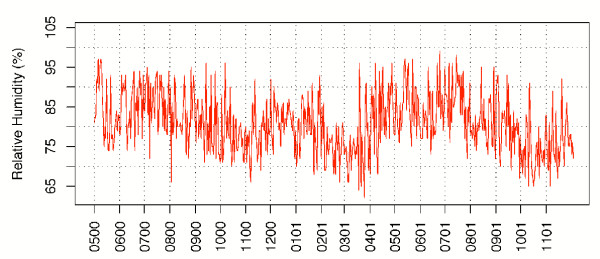
Relative humidity